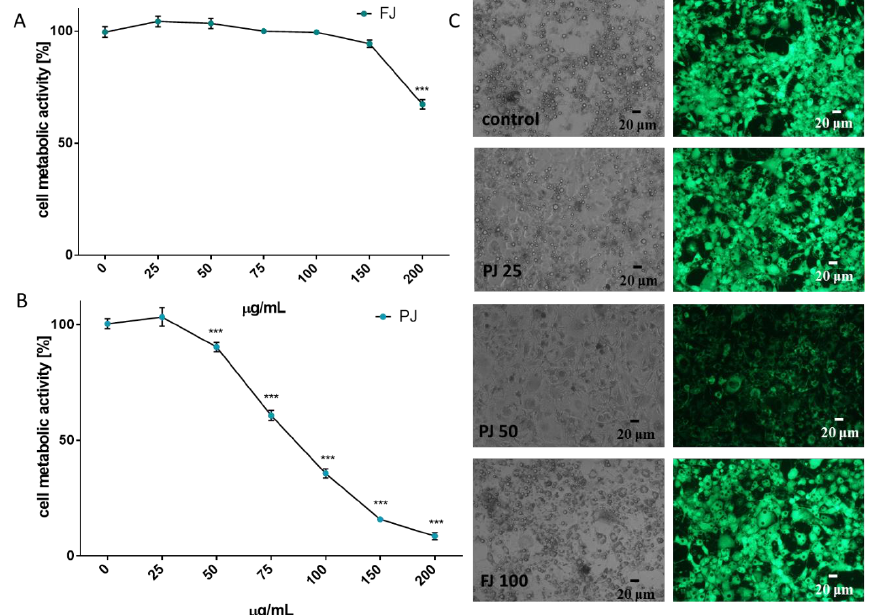
Figure 3. The influence of V. opulus FJ and PJ on 3T3L-1 cell metabolic activity determined by the PrestoBlue assay after 48 h exposure of FJ ( A ) and PJ ( B ); control cells were not exposed to any compound; values are means ± standard deviations from at least three independent experiments, n ≥ 12; statistical significance was calculated versus control cells (untreated), *** p ≤ 0.001. Morphology of 3T3L1 cells observed on the 5 th day of the cell differentiation process ( C) with 25 and 50 μg/mL of PJ, and 100 μg/mL of FJ; randomly chosen fields were photographed at × 200 phase-contrast and a fluorescent microscope (cells stained with 2 µM calcein AM).